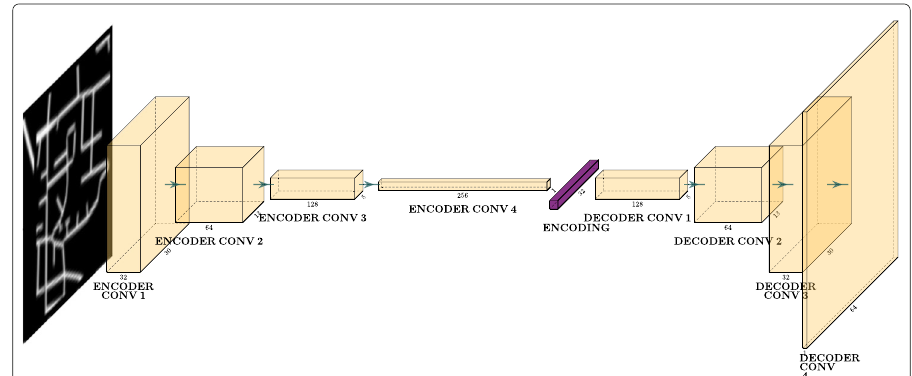
Fig. 2 Variational autoencoder architecture. Yellow blocks represent convolutional blocks (convolutional layer followed by ReLU layer) with dimensions corresponding to their output dimensions. The purple block is the learnt embedding